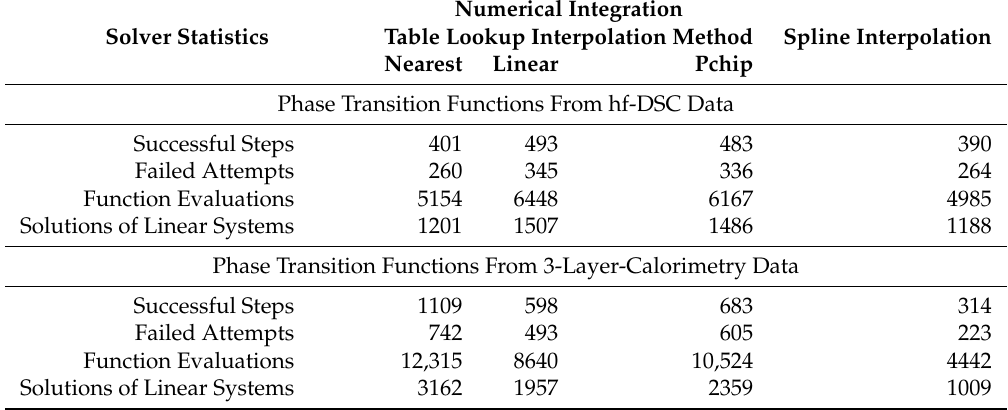
Table 3. MATLAB’s ode15s solver statistics for the solution of the transient heat conduction problem in Equation (16).